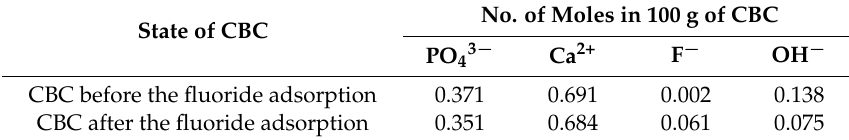
Table 5. Number of moles of PO 43 − , Ca 2+ , F − , and OH − in CBC before and after the fluoride adsorption.